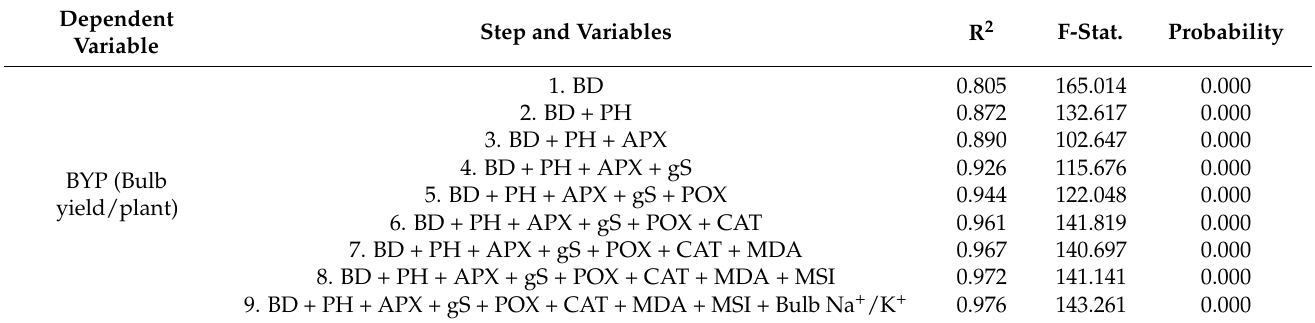
Table 8. Traits prioritization for salinity stress tolerance in onions through stepwise regression